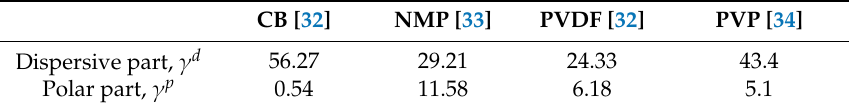
Table 1. Dispersive and polar part of surface energy of CB, NMP, PVDF and PVP.